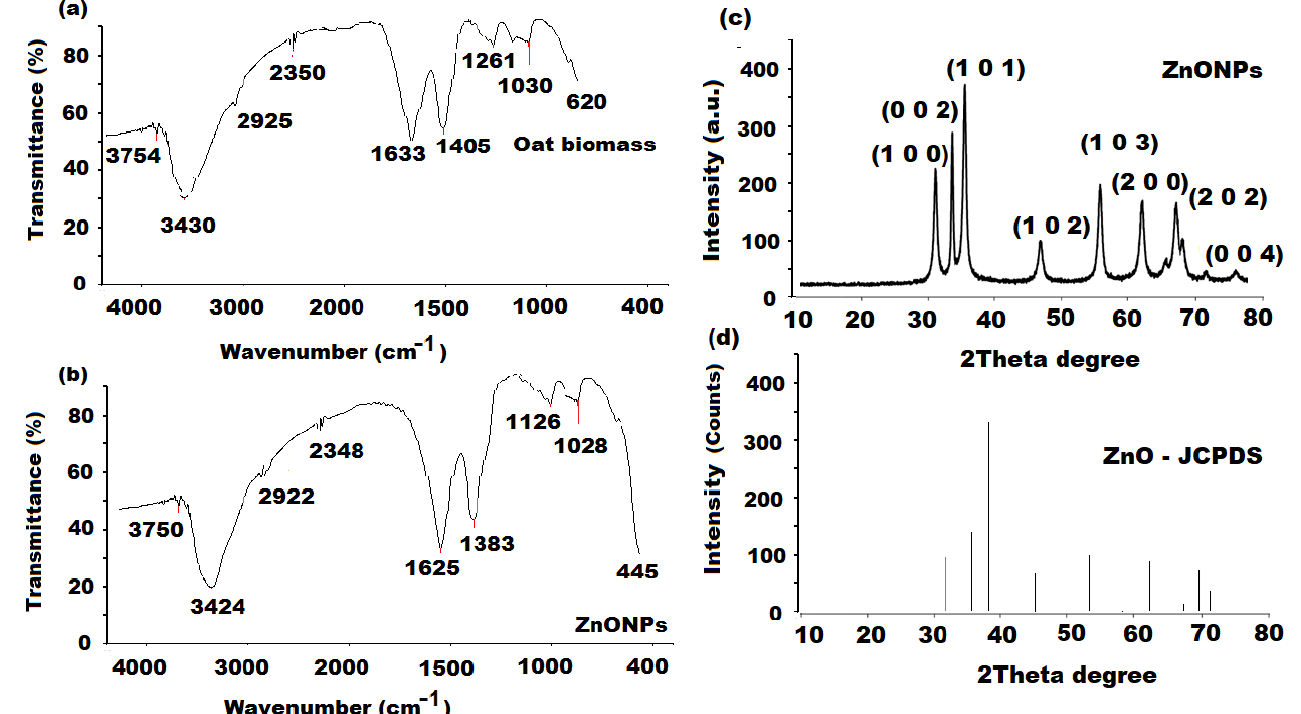
Figure 3. FT-IR spectra of ( a ) oat biomass and ( b ) ZnONPs at wave numbers in the range 4000–400 cm − 1 and XRD analysis of ( c ) ZnONPs synthesized using oat biomass and ( d ) standard ZnO given by JCPDS (card number: 01-089-1397).